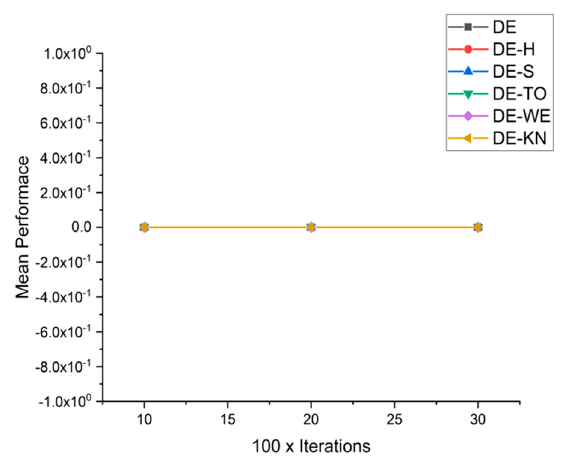
Figure 31. Convergence curve on fn9.